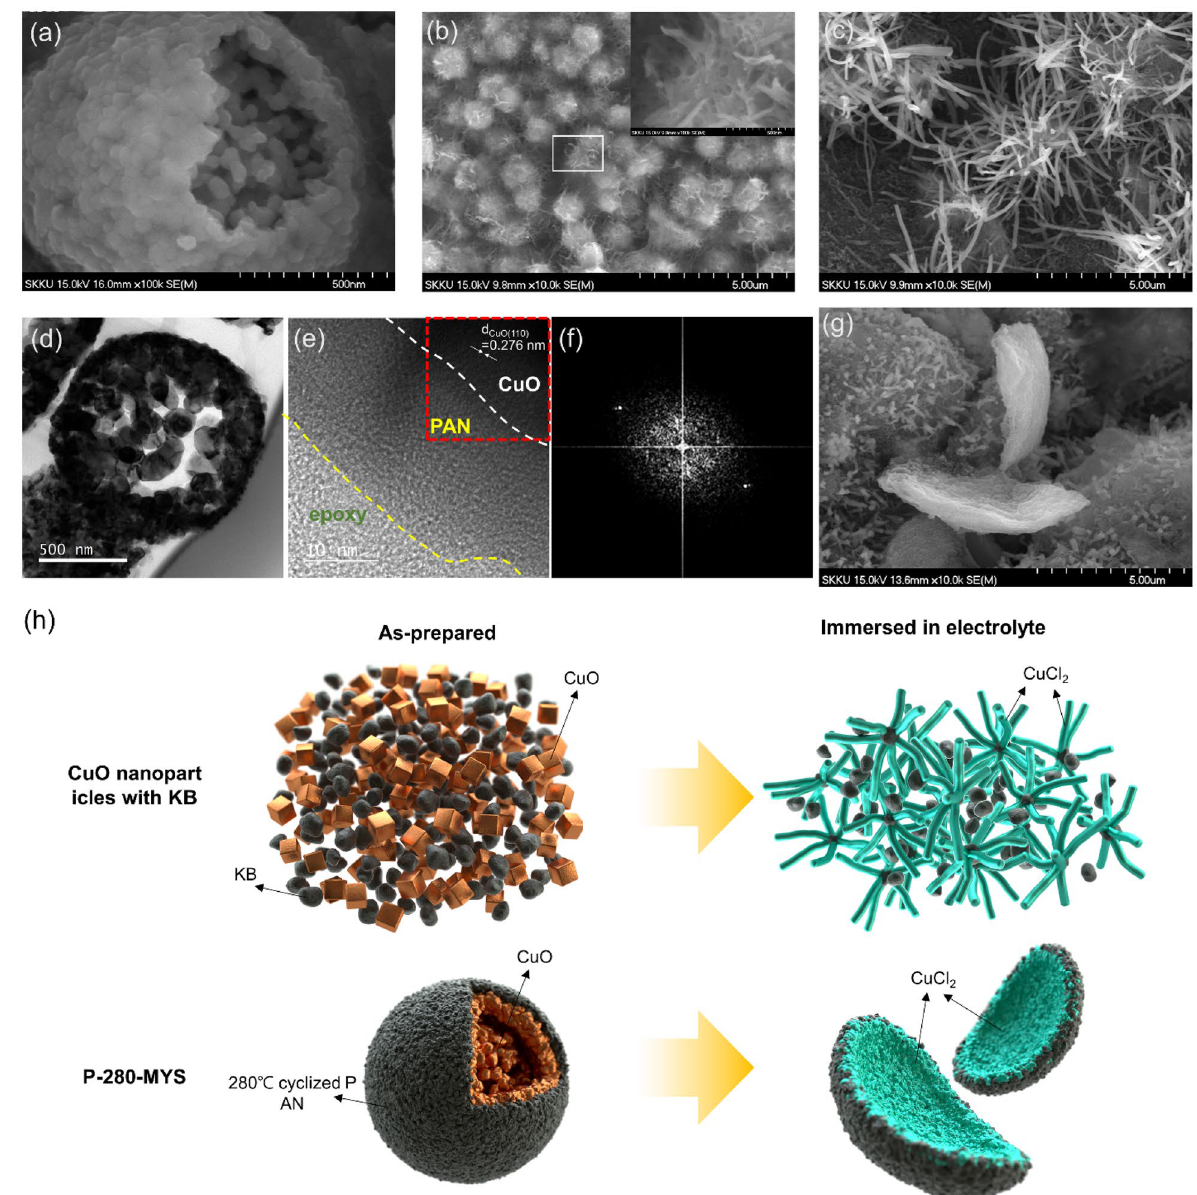
Fig. 1 Field‑emission scanning electron microscopy images of the a as‑prepared multi‑yolk–shell CuO (MYS‑CuO) microspheres, b carbon‑free MYS‑CuO cathode (CuO: polytetrafluoroethylene (PTFE) 6:2), and c Ketjen black (KB)‑containing MYS‑CuO cathode (CuO: KB: PTFE 6:2:2) = = after immersion in the electrolyte. d Transmission electron microscopy (TEM), and e high‑resolution TEM images of polyacrylonitrile (PAN)‑coated MYS‑CuO microspheres cyclized at 280 °C. f Fast Fourier transform pattern of the area enclosed by the red dashed square in e . g KB‑and‑PAN‑containing MYS‑CuO cathode cyclized at 280 °C (CuO: KB: PAN: PTFE 6:2:1:1) after immersion in the electrolyte. h Schematic of the = structural transformation of the active cathode materials: without carbon coating (top row), with carbon coating (bottom row), before immersion in the electrolyte (left column), and after immersion in the electrolyte (right column). The black and tan squares represent KB particles and MYS‑CuO microspheres,